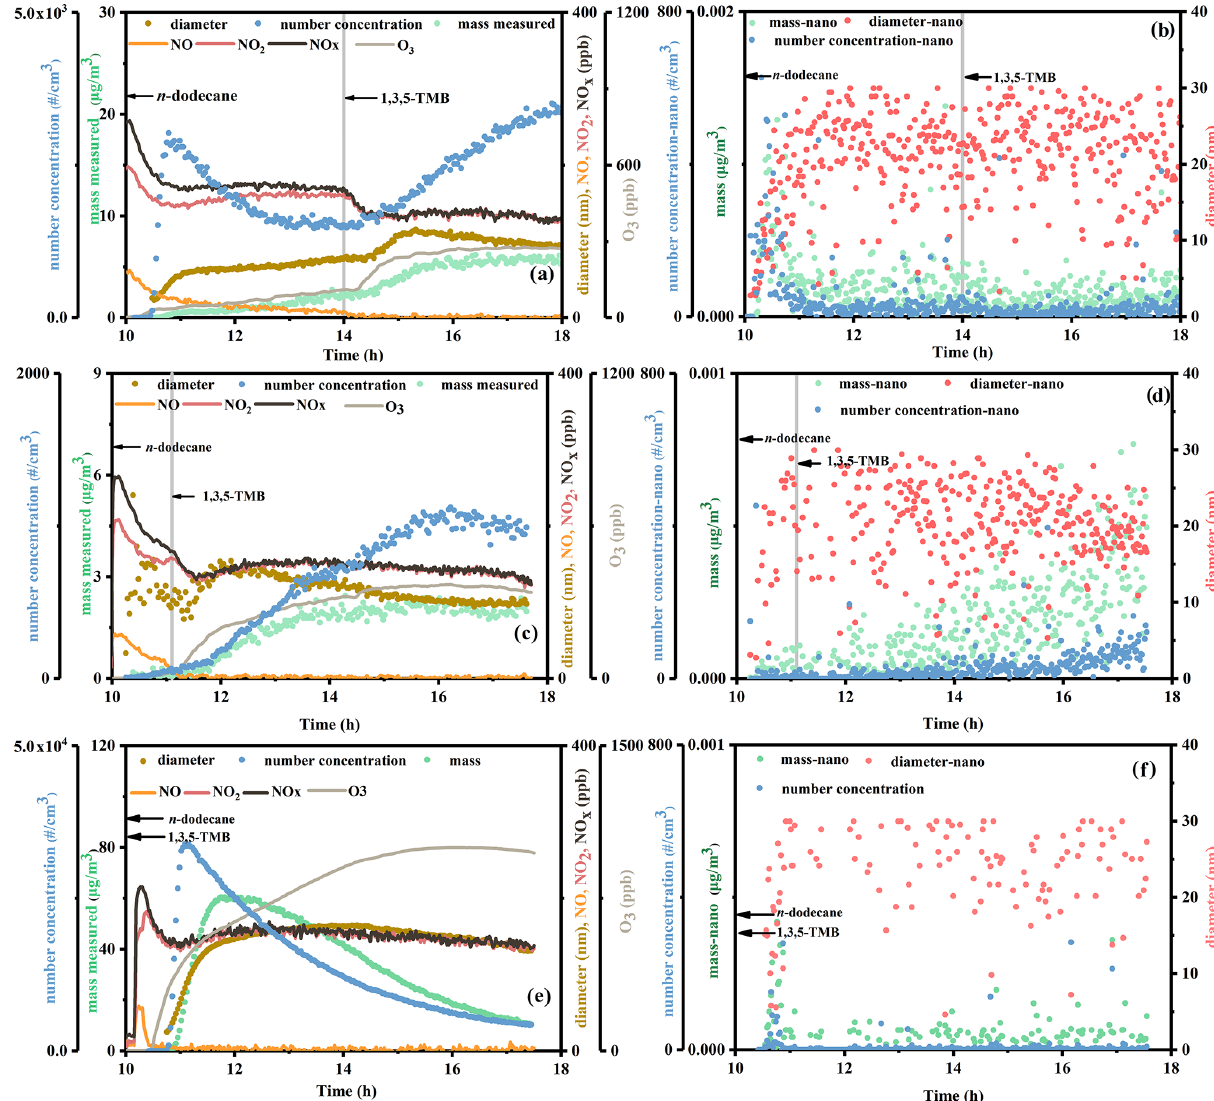
Figure 3. (a) Reaction profiles of experiment MIX-6, (b) time series of particles in the size range of 0–40nm for MIX-6, (c) reaction profiles of experiment MIX-7, (d) time series of particles in the size range of 0–40nm for MIX-7, (e) reaction profiles of experiment MIX-4, and (f) time series of particles in the size range of 0–40nm for MIX-4. The concentrations of mass and number concentration of particles are shown on the left axes, while the diameter of particles and concentrations of NO, NO 2 , NO x , and O 3 are shown on the right axes. The vertical gray lines in the figures refer to the time that 1,3,5-TMB was